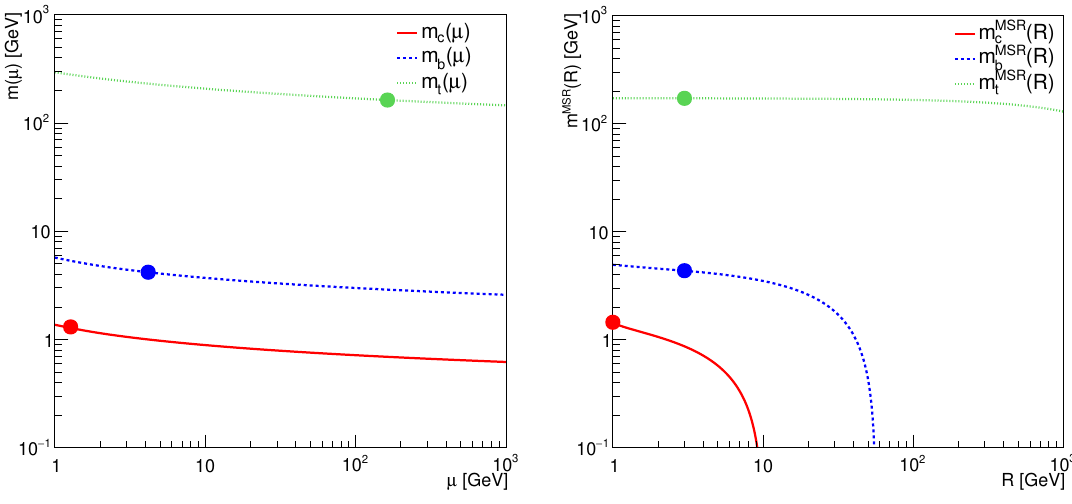
Figure 1 . The one-loop evolution of the MS charm-, bottom- and top-masses for varying renor- malization scales µ (left). The one-loop evolution of the MSR charm-, bottom- and top-masses for varying scales R (right). The values of µ and R used in the subsequent calculations and figures of this work are marked with filled dots. The value of α S ( M Z ) is fixed to 0.118 and α S is evolved at four loops, as in table